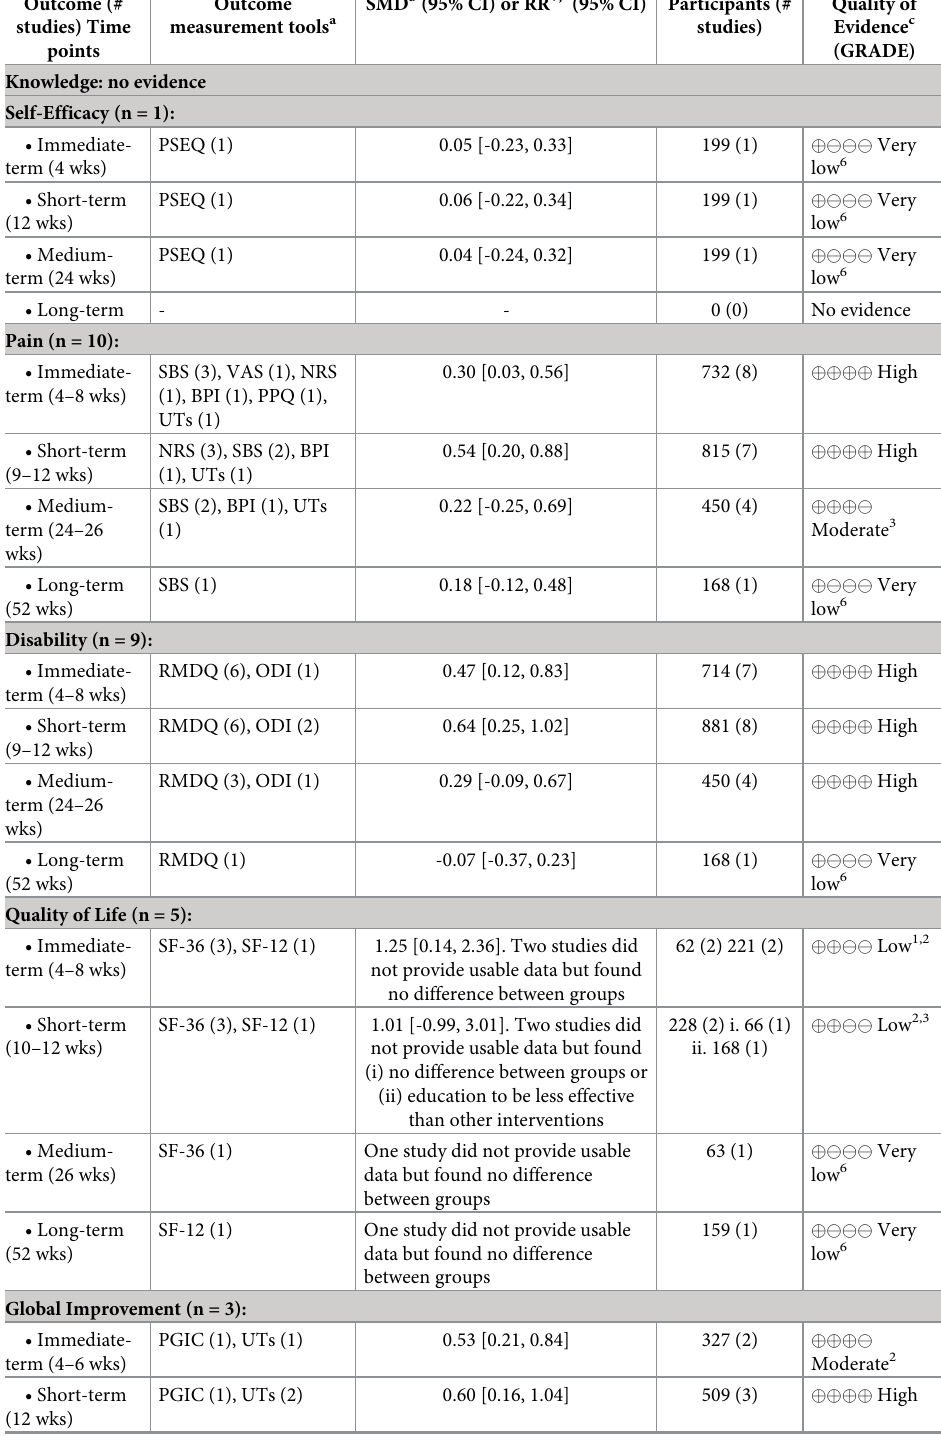
Table 7. Summary of findings: Education materials compared with another intervention for chronic low back